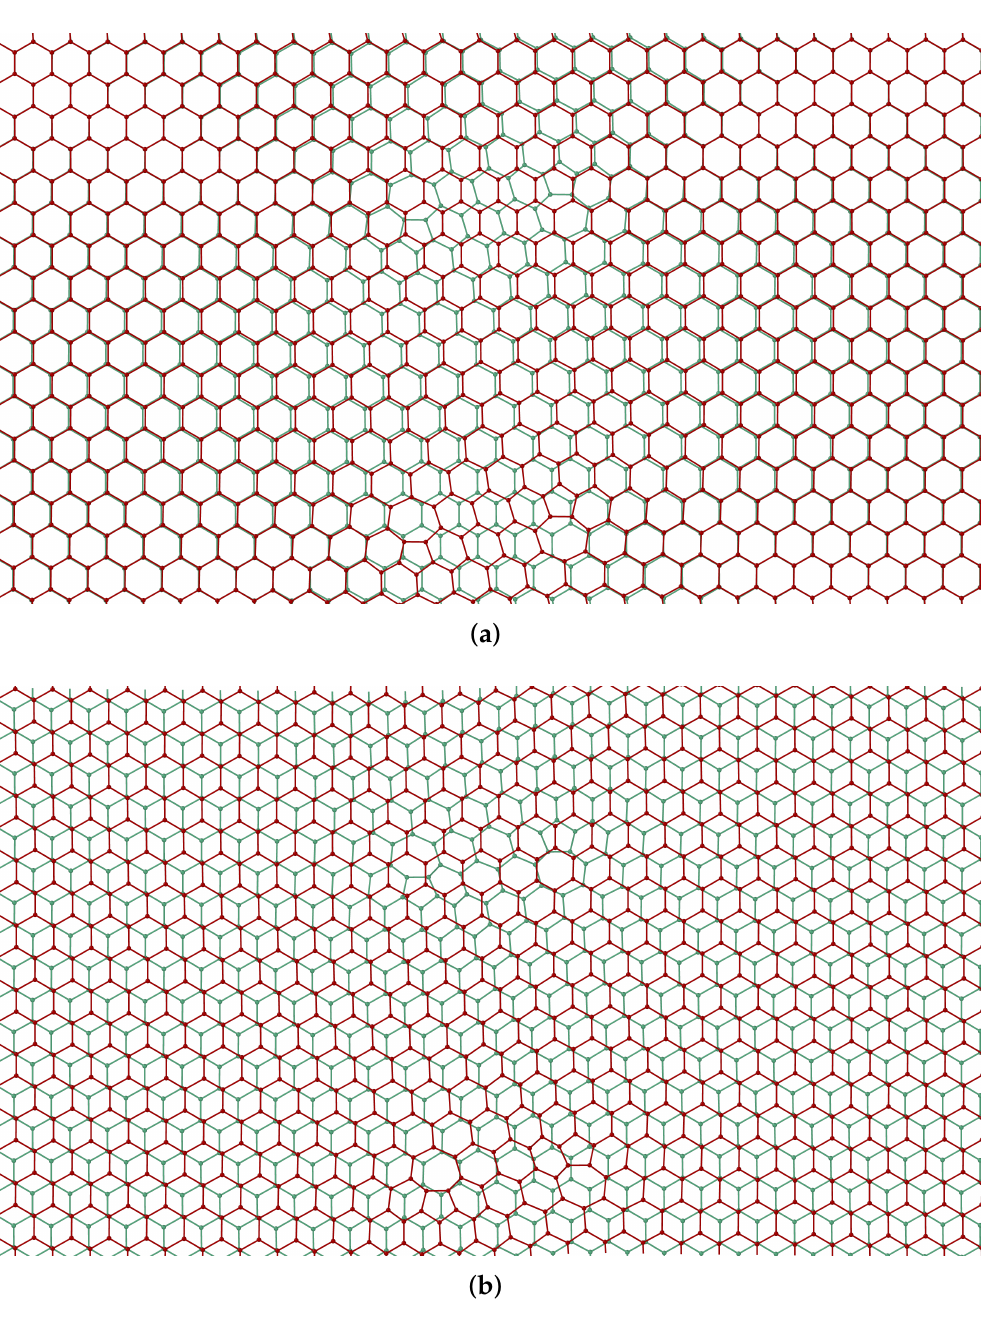
Figure 14. (a) Initial AA stacking of bilayer graphene with matching dipoles. (b) Relaxed configuration Figure 14. ( a ) Initial AA stacking of bilayer graphene with unmatched dipoles. ( b ) Relaxed configuration showing dislocation core structure and AB showing dislocation core structure and AB stacking.